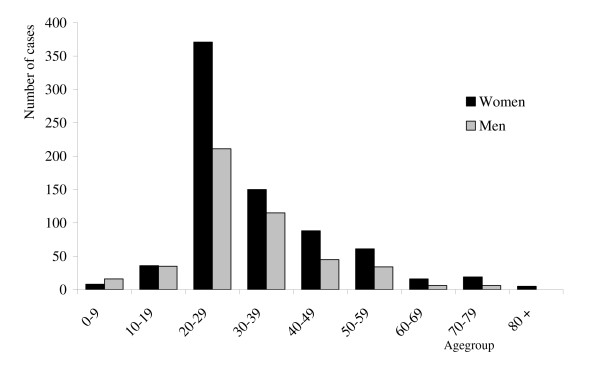
Age- and sex-distribution, giardiasis in Bergen municipality 1/9/2004 – 1/2/2005 (n = 1222).